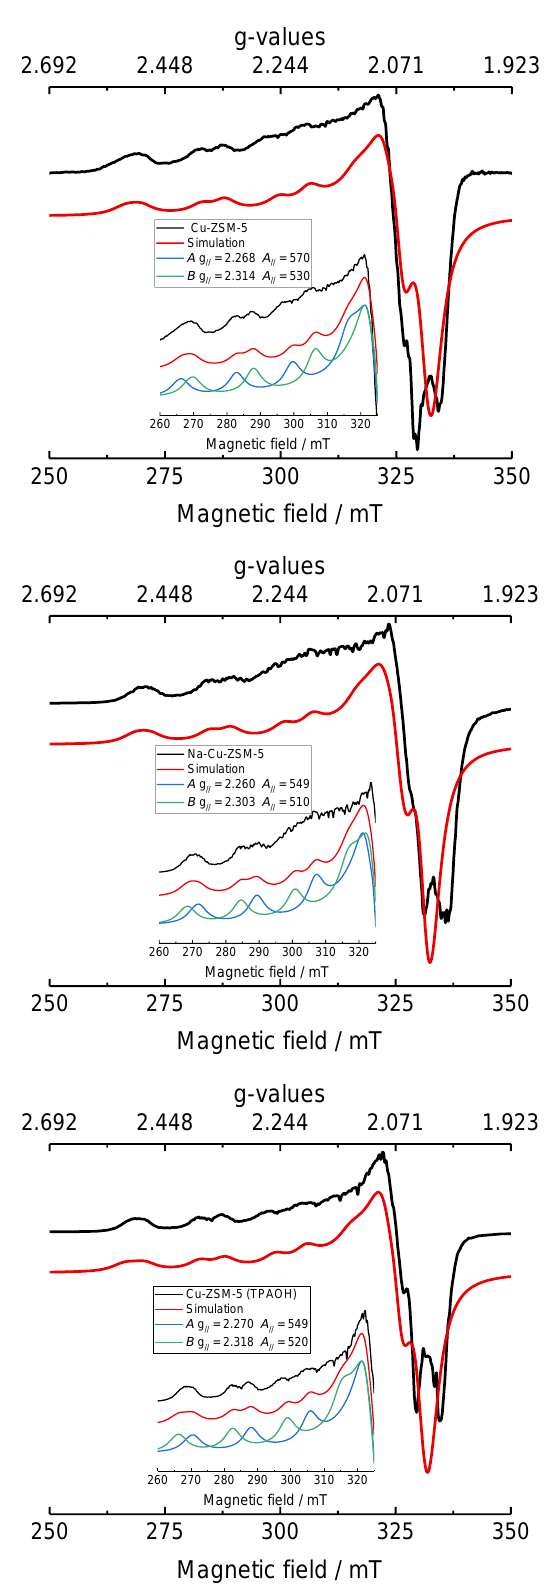
Figure 9. Experimental (black) and simulated (red) spectra of the dehydrated Cu-exchanged ZSM-5. The low field part of the experimental and simulated spectrum is reported on the bottom left of each spectrum. The simulation is obtained by summing the spectra of two different Cu species ( A in blue and B in green) with a proper